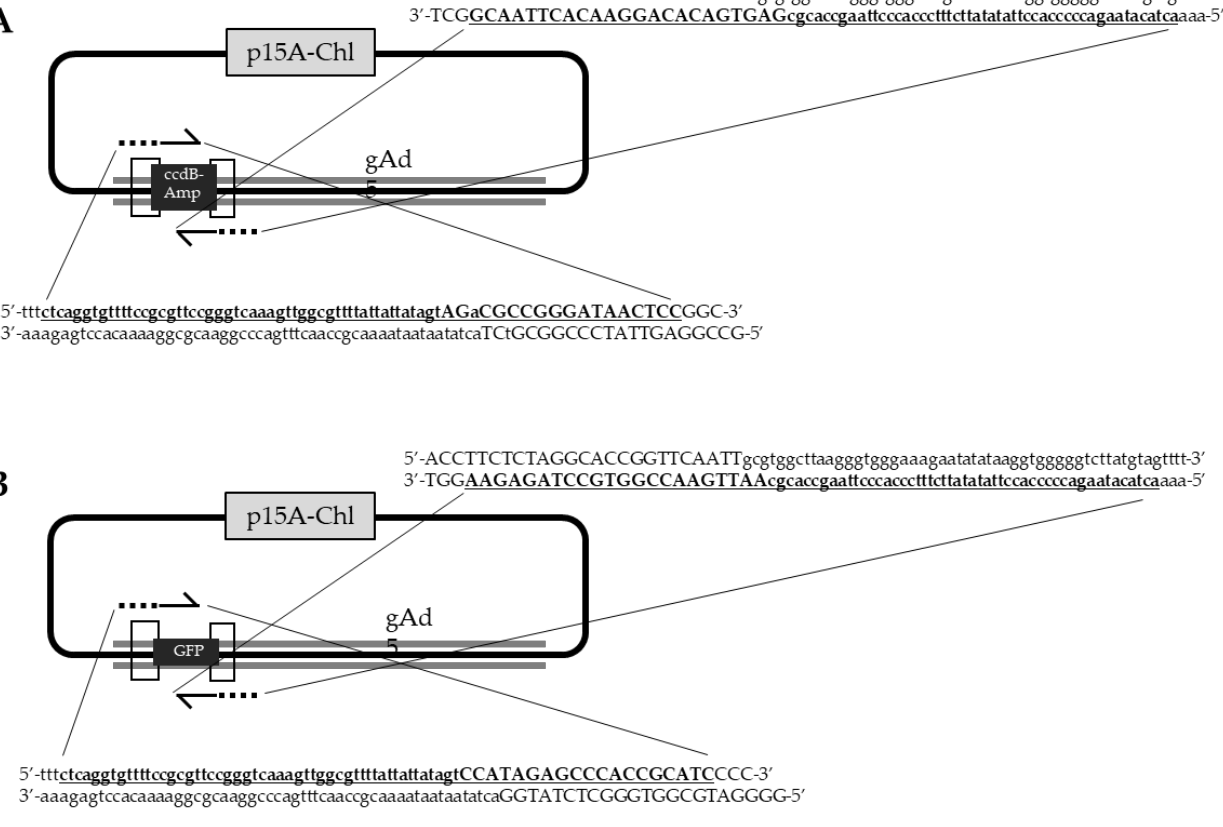
Figure 4. Example of oligonucleotide design for adenovirus genome engineering: transgene insertion into E1 region of adenovirus type 5 (Ad5). ( A ) Counter-selection marker (SM) ccdB-Amp insertion. ( B ) Transgene, here GFP, insertion. Forward- and reverse-primers are bold and underlined, capital letters are primer binding sequences, while lower case are homology arms.